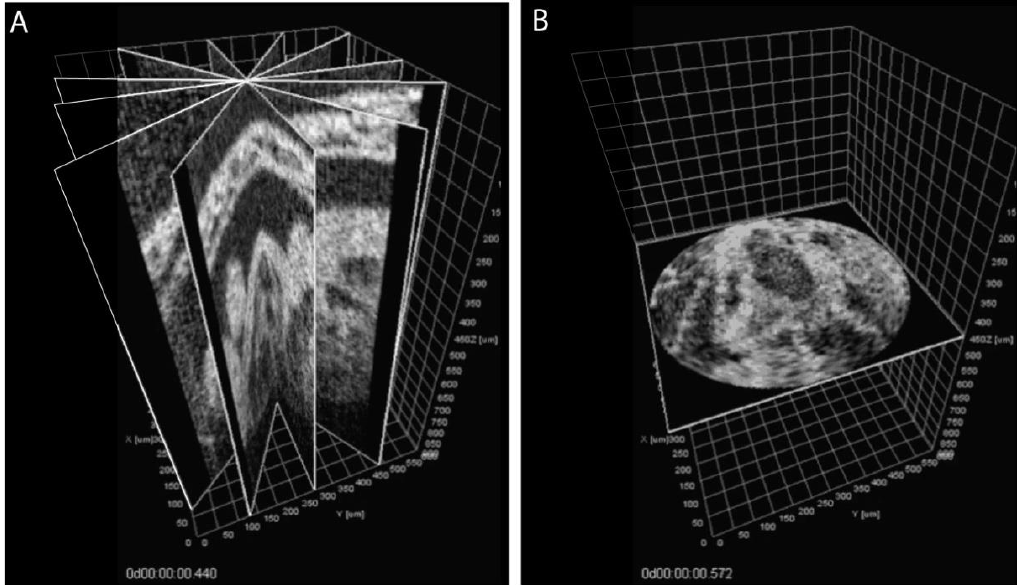
Figure 3. Sequential Turning Acquisition and Reconstruction (STAR) method for embryonic cardiodynamic analysis. ( A ) Representative cross-sections through the synchronized reconstruction demonstrating the positions of the imaging planes (6 out of 60 angles). ( B ) XY cross-section of STAR data after polar-to-Cartesian interpolation. Reproduced with permission from [47].